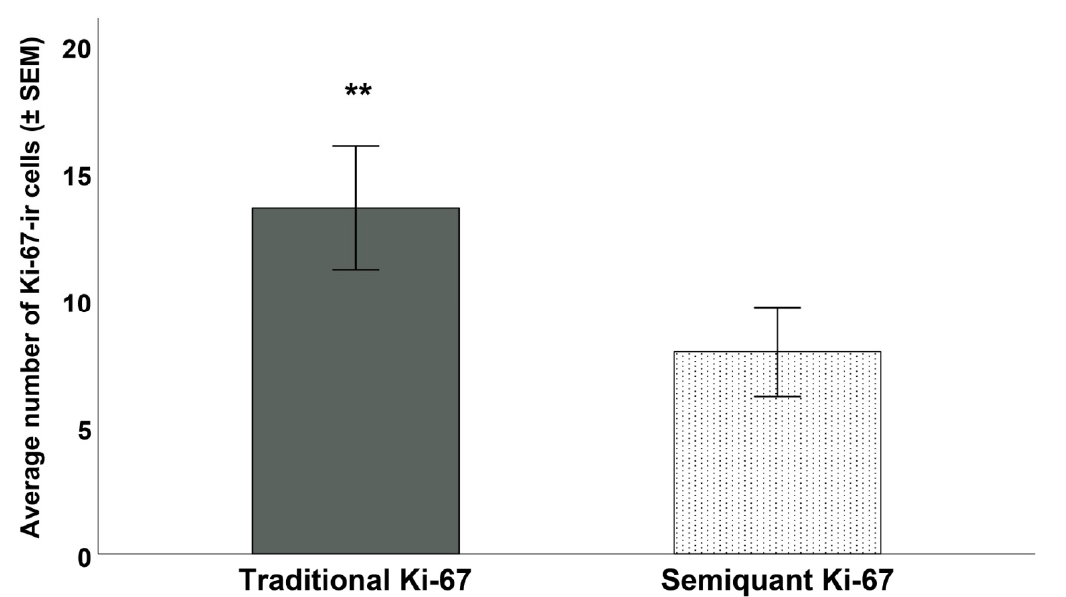
Figure 3. The average number of cells expressing Ki-67 varied significantly according to the method used (** = p < 0.001). On the left the average values counted using the traditional evaluation is shown; on the right the new semiquantal evaluation was